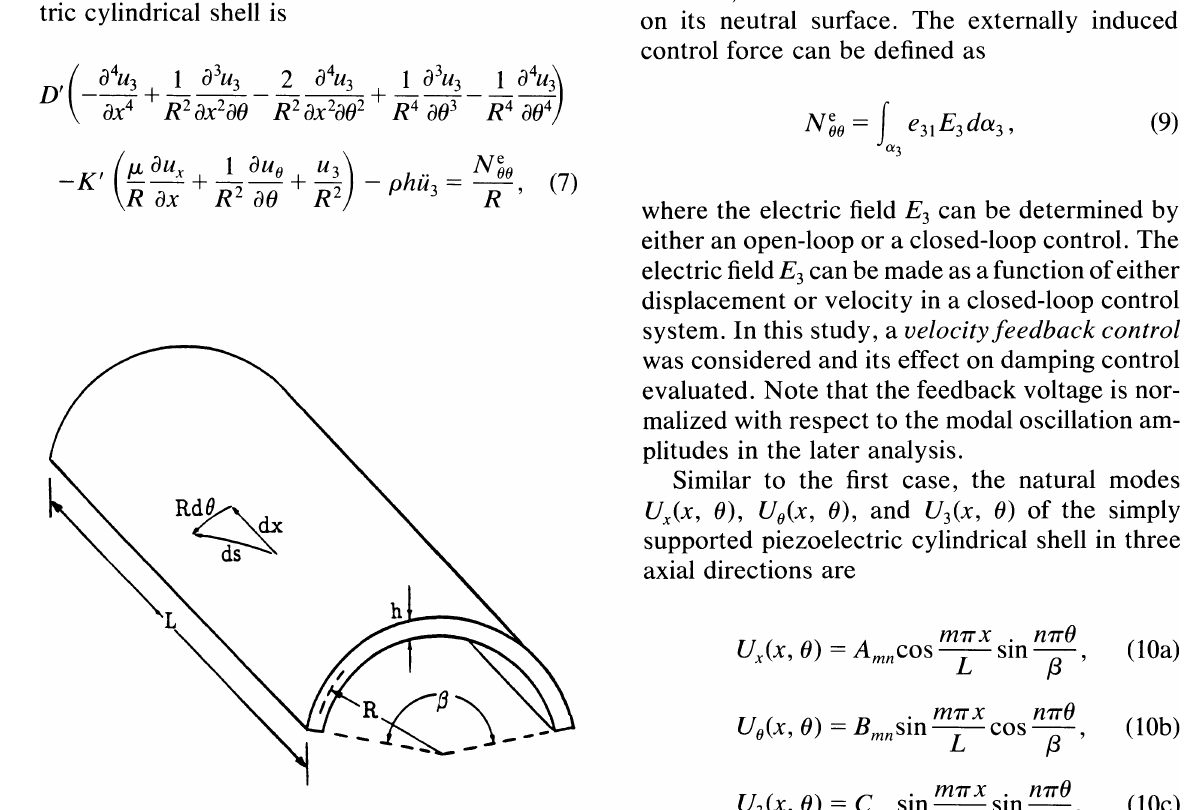
FIGURE 2 A piezoelectric cylindrical